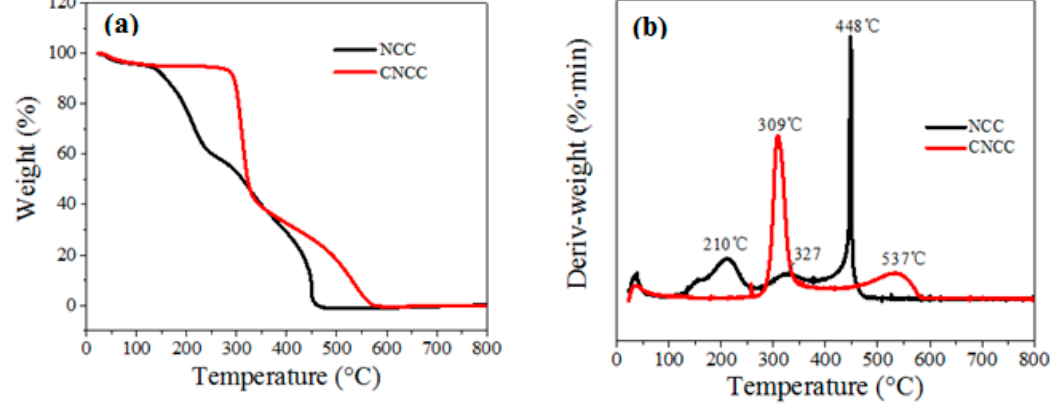
Figure 2. ( a ) TG and ( b ) differential TG (DTG)-curves for NCC and CNCC.